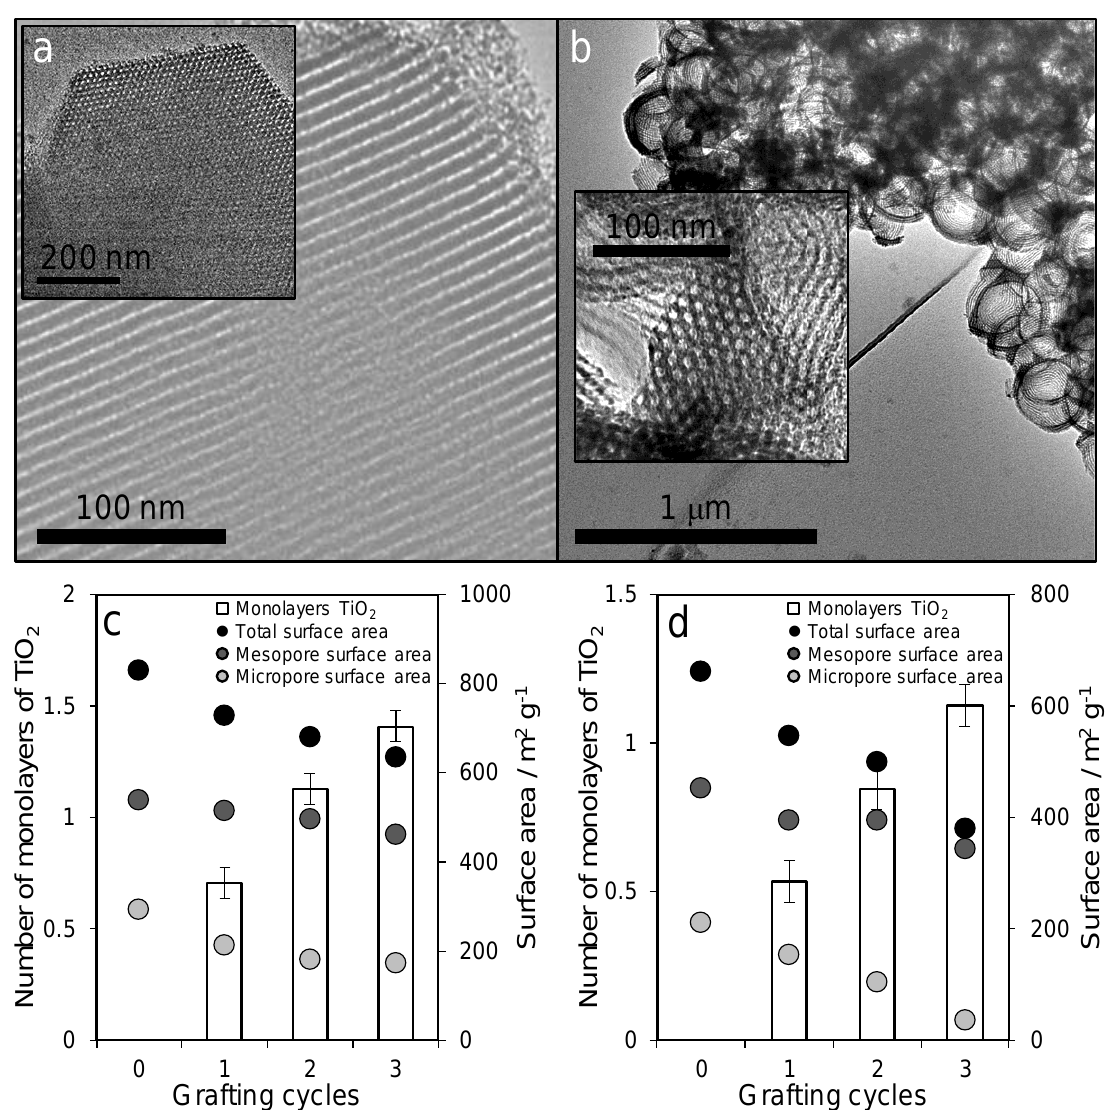
Figure 2. Bright-field transmission electron microscopy (TEM) images of ( a ) TiO 2 /SBA-15 (3 rd cycle grafting), and ( b ) TiO 2 /MM-SBA-15 (3 rd cycle grafting) highlighting ordered hexagonally close-packed mesopores and uniform macropores, and the evolution of textural properties and calculated TiO 2 monolayer thickness as a function of grafting cycle for ( c ) TiO 2 /SBA-15 and ( d ) TiO 2 /MM-SBA-15.